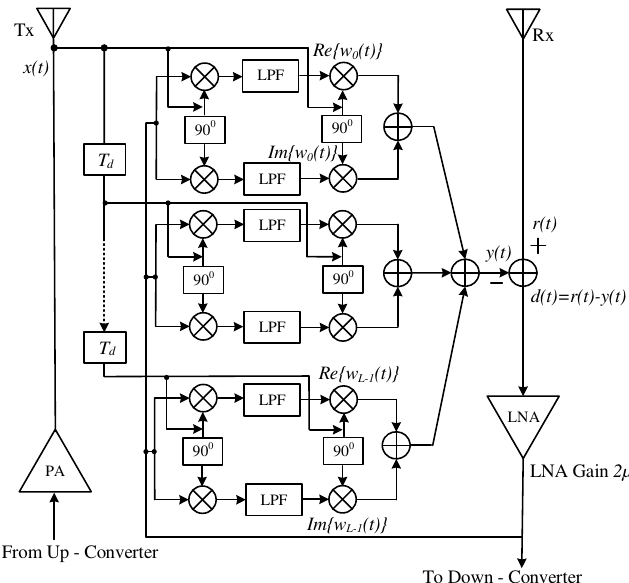
Figure 2. The ALMS loop